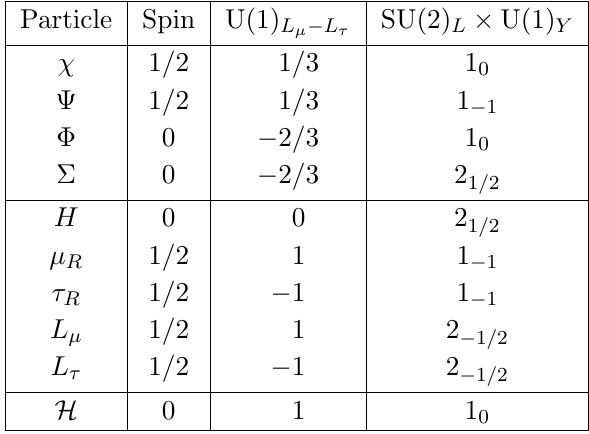
Table 4 . Particle content of the lepton number dark matter model. The top section contains the same matter as the theory of section 5; the middle section contains SM particles; and the last is (a possible choice for) the additional Higgs that breaks the new gauge